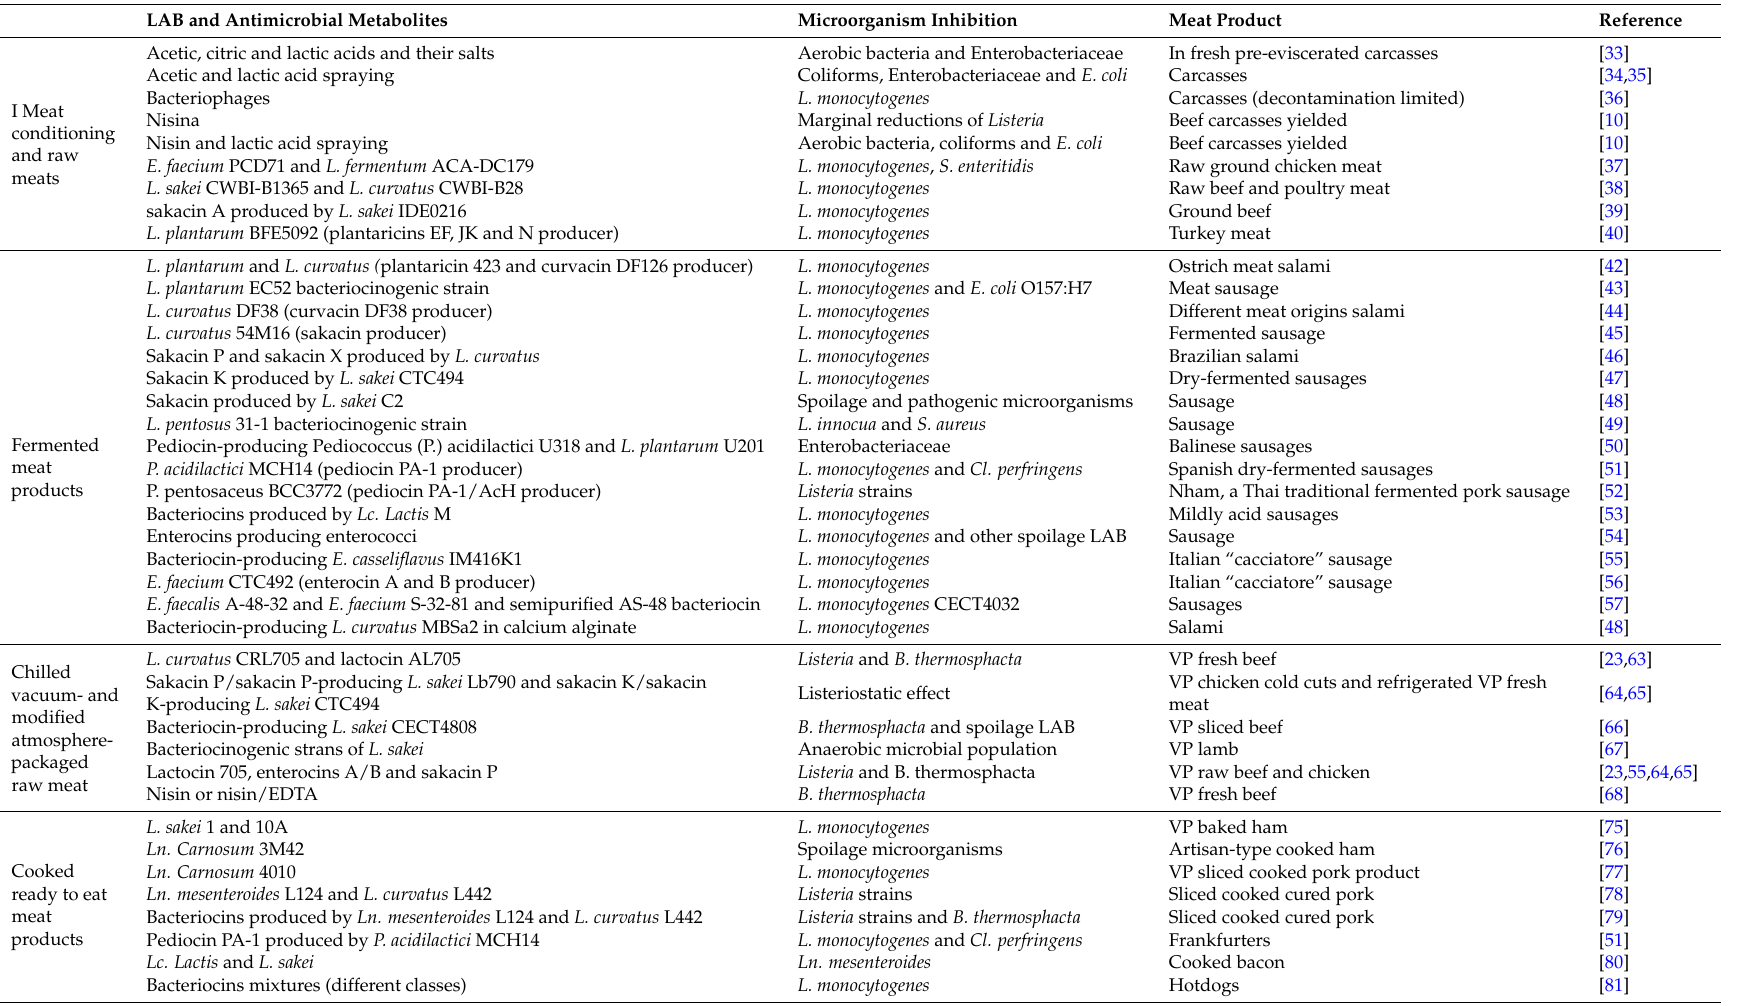
Table 1. Antimicrobial interventions of LAB and their metabolites on different meat